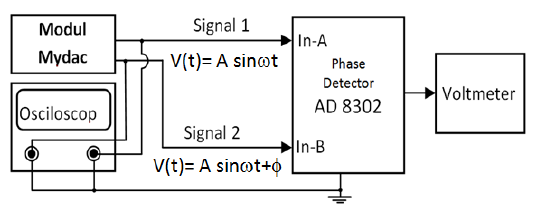
Figure 8. The set up for the linearity test of Phase Detector circuit.